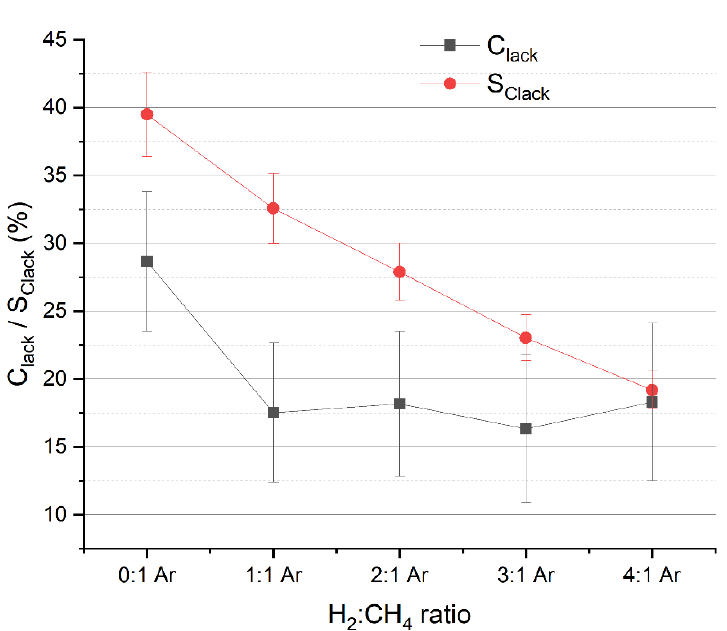
Figure 4. Changes in soot yield and selectivity with the increase of H 2 :CH 4